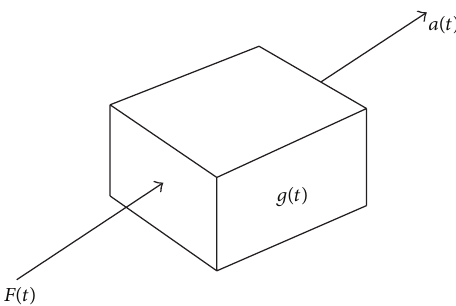
Figure 4: Schematic representing a linear, time-invariant